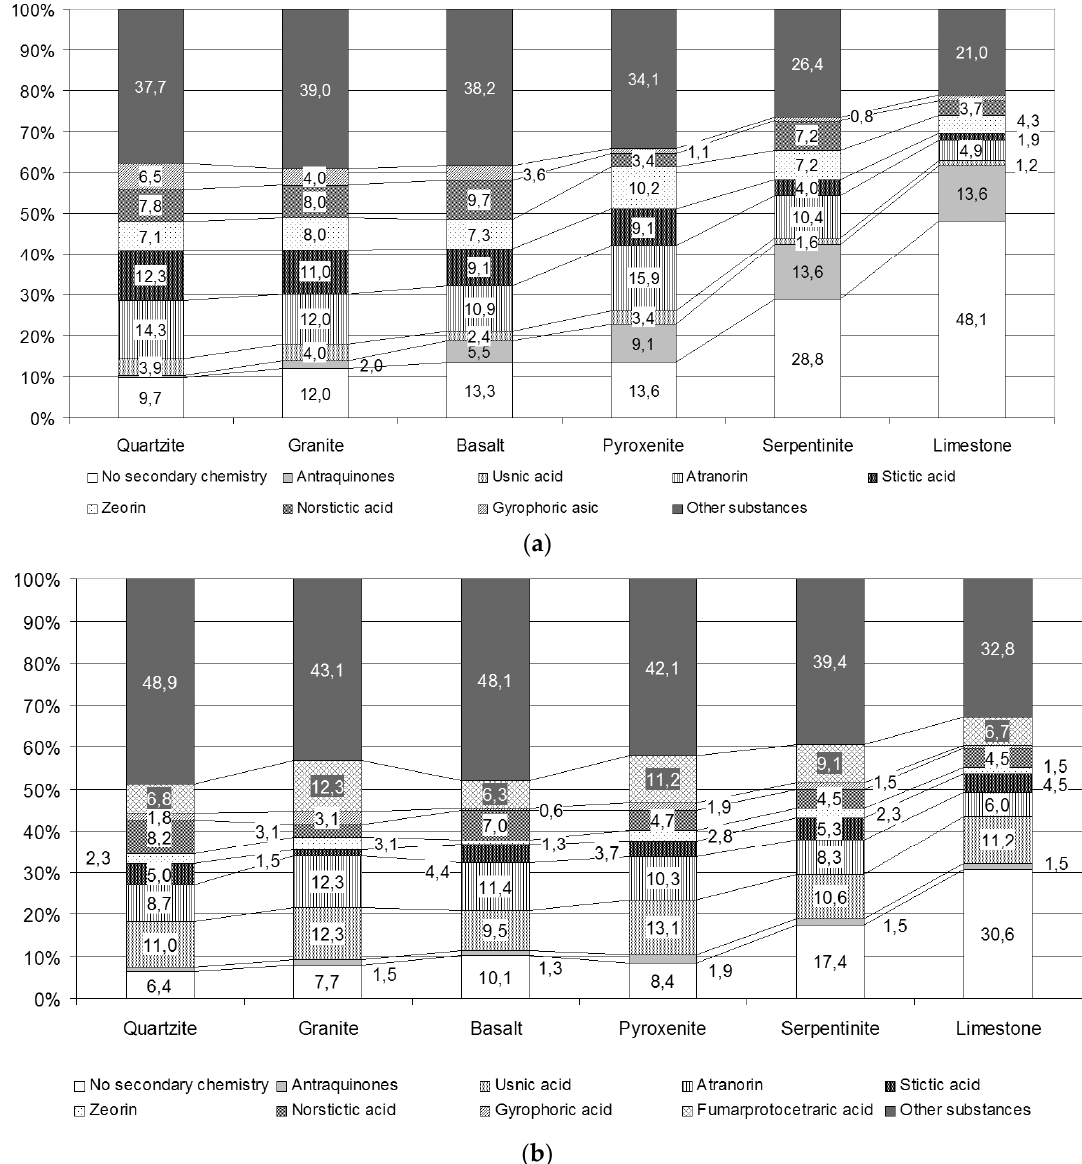
Figure 3. Percentage of lichen species containing eight major secondary metabolites on different rock types. ( a ) crustose species, ( b ) foliose and fruticose species.